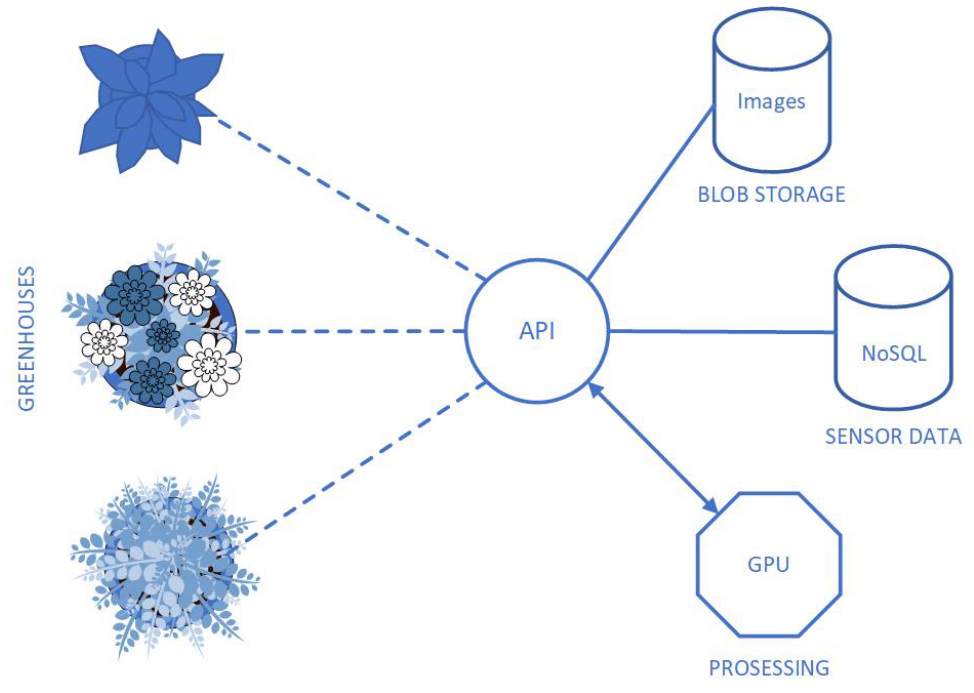
Figure 4. The high-level system